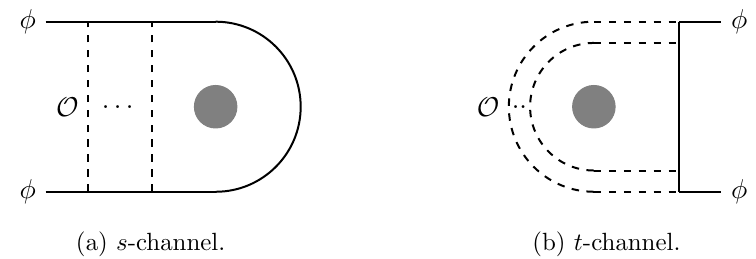
Figure 10. Higher order terms (cid:14) m log m (cid:22) z that sum up to shift the [ (cid:30)(cid:30) ] poles in a ((cid:1) ; J ) are [ (cid:30)(cid:30) ] produced by sums over multi-twist families in the t -channel.